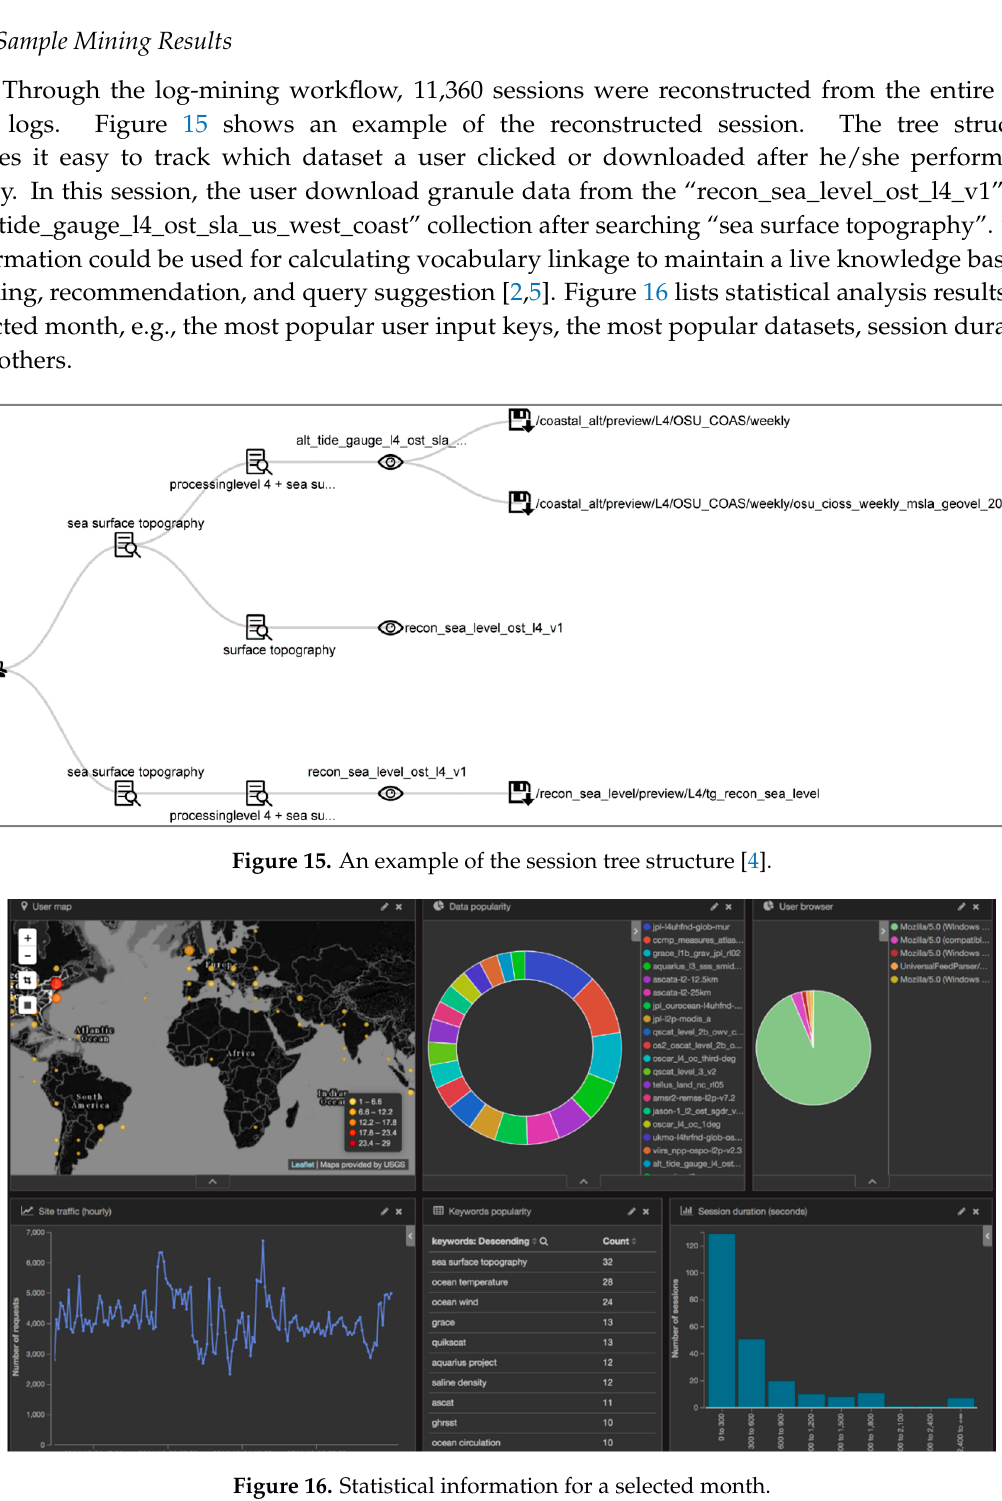
Figure 16. Statistical information for a selected month.